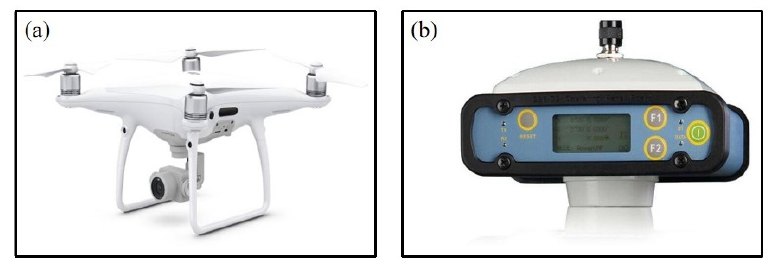
Figure 2. The UAV and RTK system. Note: ( a ) represents the DJI Phantom 4 Pro V2.0; ( b ) represents the RTK S86T system.